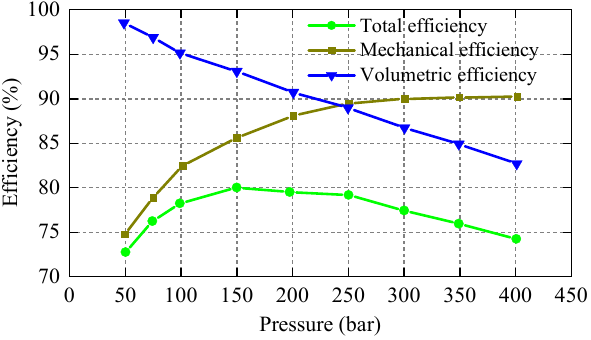
Figure 7. Efficiency characteristics of the hydraulic components.